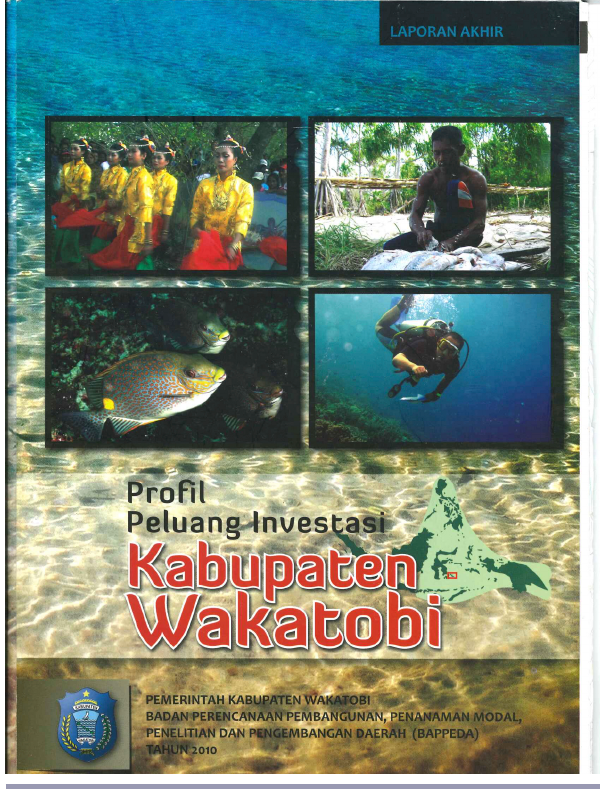
Fig. 3 . Cover of investment book.